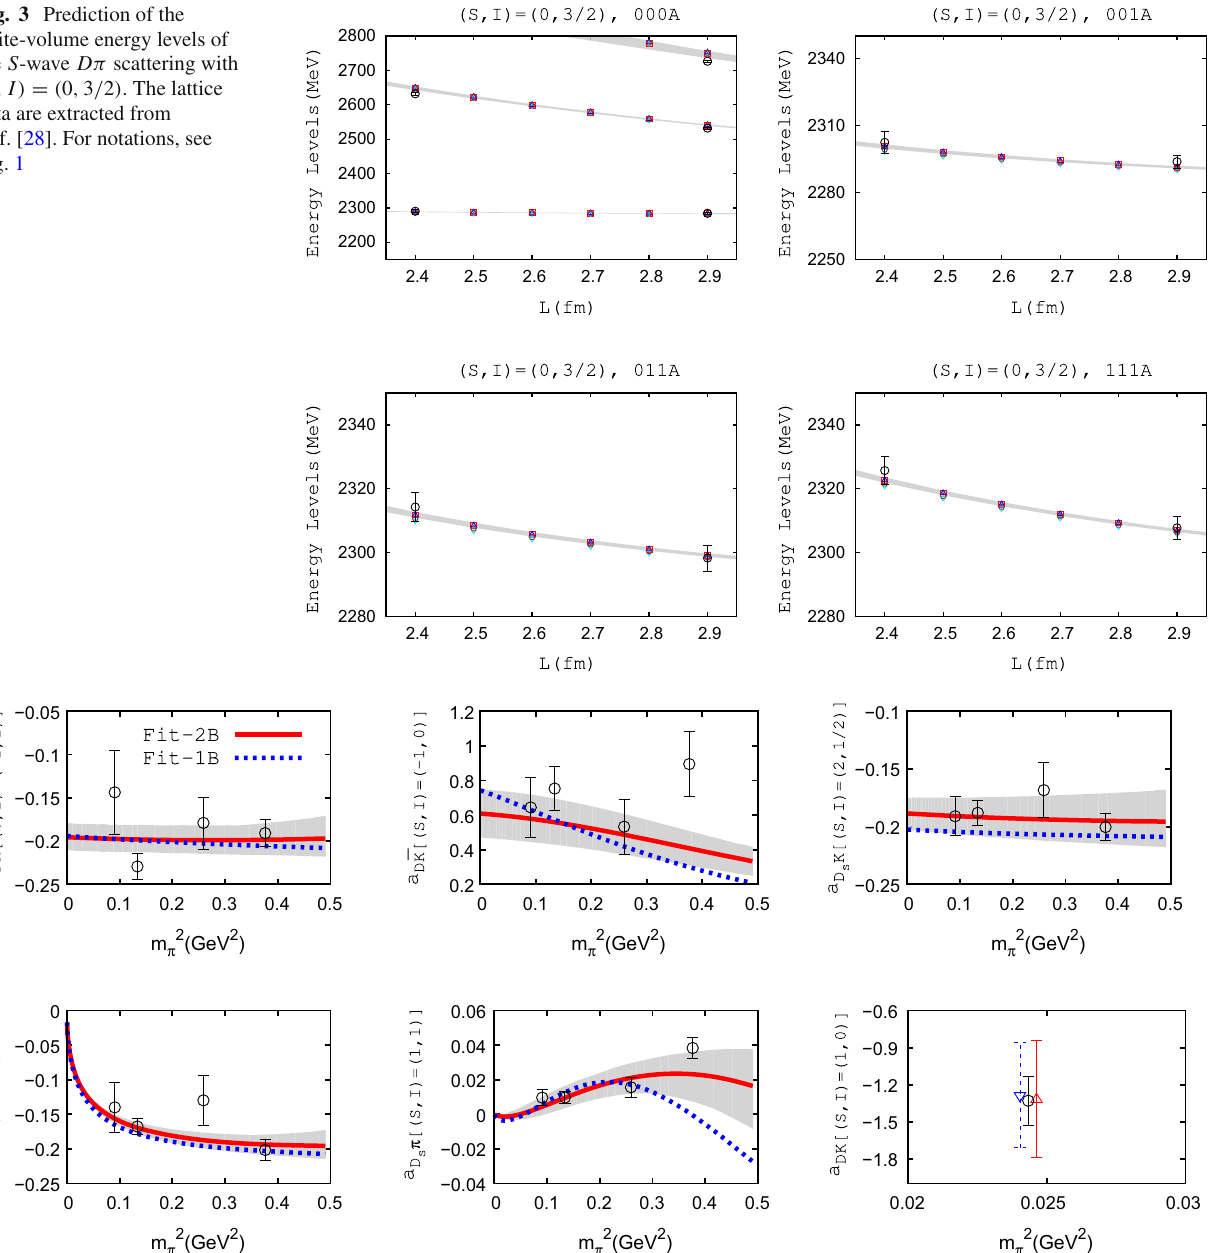
Fig. 4 Reproduction of various scattering lengths. The last panel in the right bottom corner denotes the results of the S -wave DK scatter- ing with ( S , I ) = ( 1 , 0 ) and the lattice data are taken from Ref. [26], where only the 2 + 1 flavor lattice simulation is considered. The lattice are given in the left and right panels in Fig. 5,